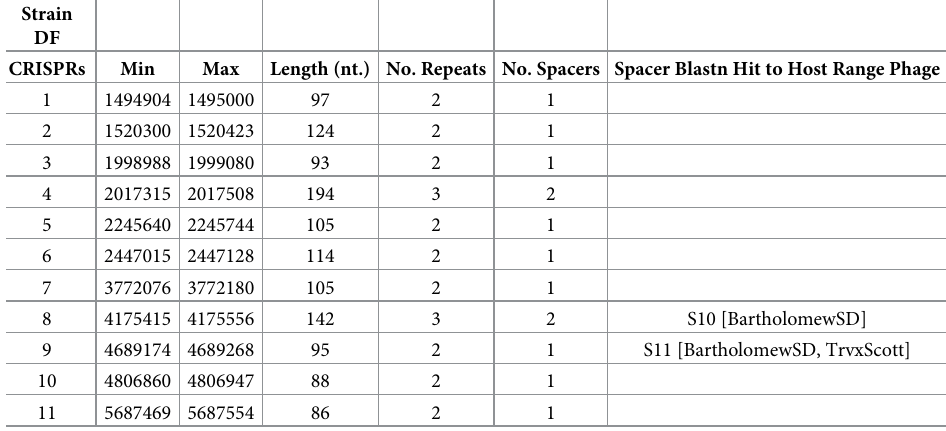
Table 12. Characteristics of the 11 CRISPRs predicted in the complete genome sequence of strain DF.